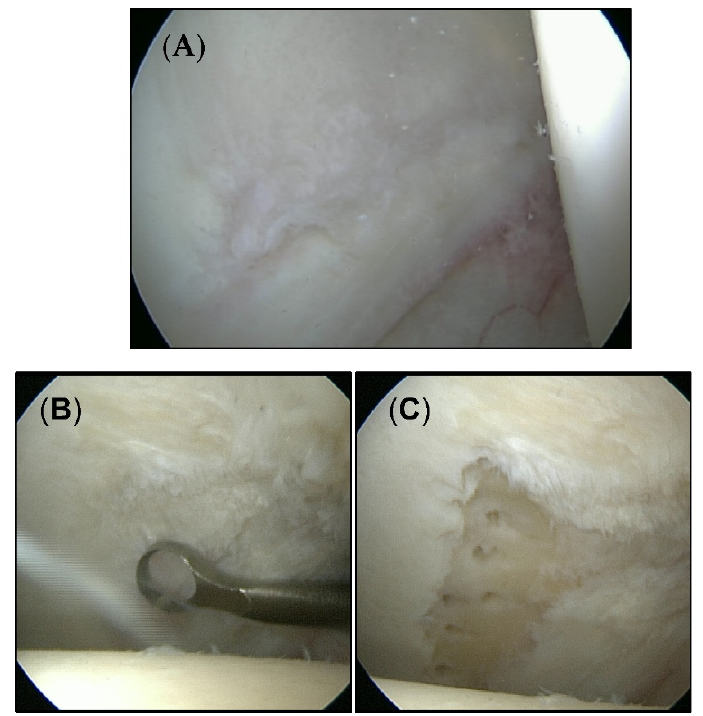
Figure 1. Intraoperative appearance of cartilage defects. ( A ) Untouched defects form the untreated group. ( B ) Cartilage defect from the microfracture group before ( C ) and after treatment.